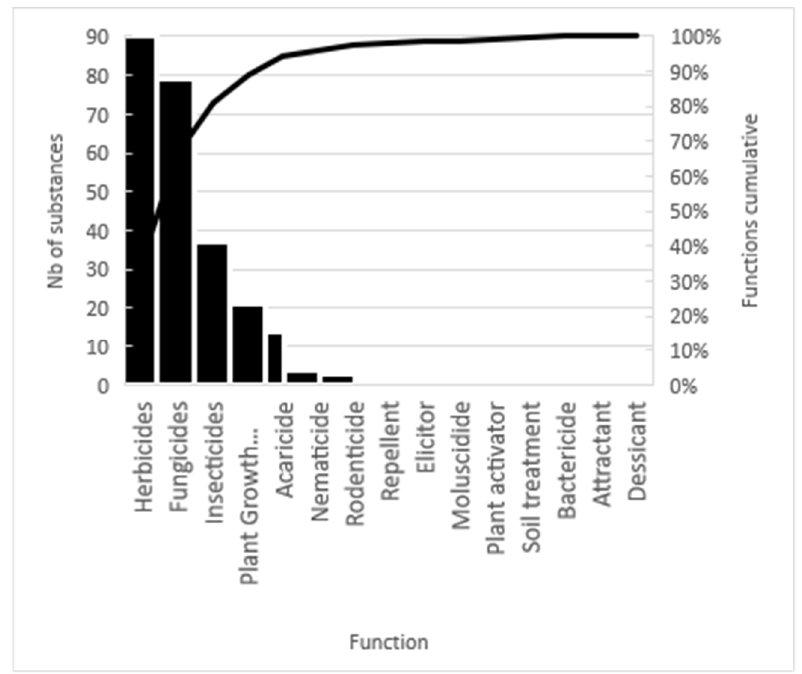
Figure 1. Cumulative functions of chemicals.